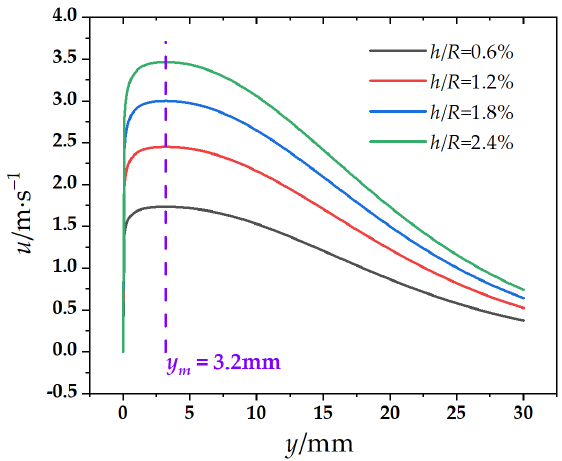
Figure 11. Relation between velocity and particle diameter under four different h / R .